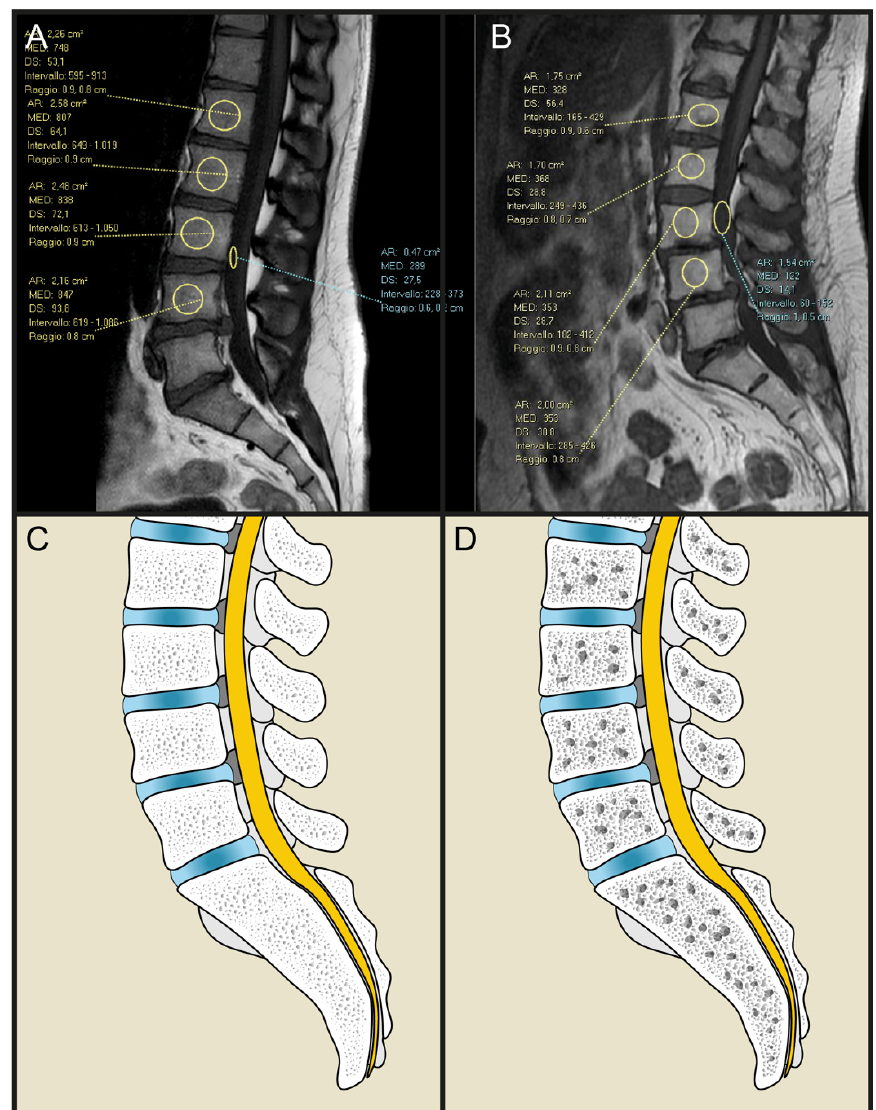
Figure 3. Examples of a high (left) and low (right) M scores. ( A ) Example of high M-score values in an MRI of the spine in sagittal view; ( B ) example of low M-score values in an MRI of the spine in sagittal view; ( C ) example drawing of a non-osteopenic spine (high M score); ( D ) example drawing of an osteopenic spine (low M score).